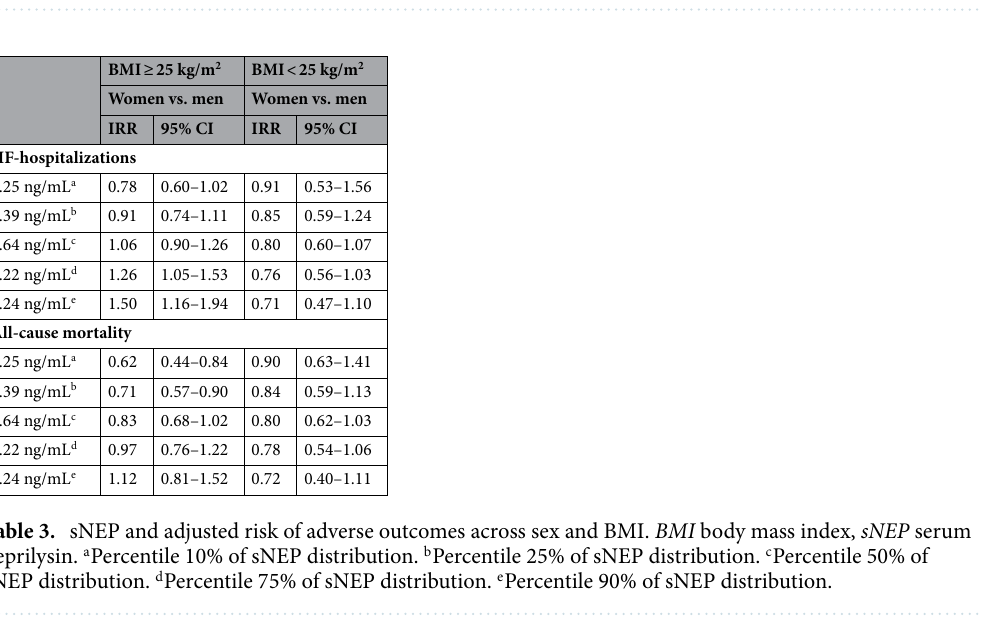
Figure 2. Soluble neprilysin and excess hospitalization risk in women versus men across body mass index values. BMI: body mass index.